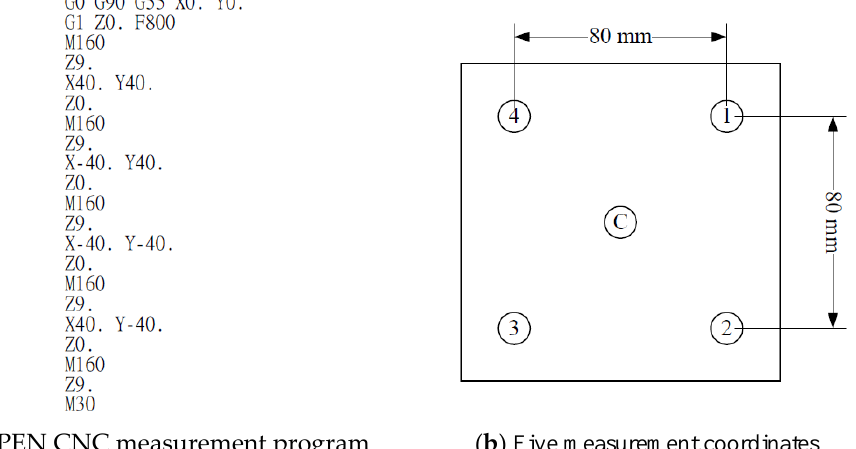
Figure 4. OPEN CNC measurement program and five measurement coordinates.